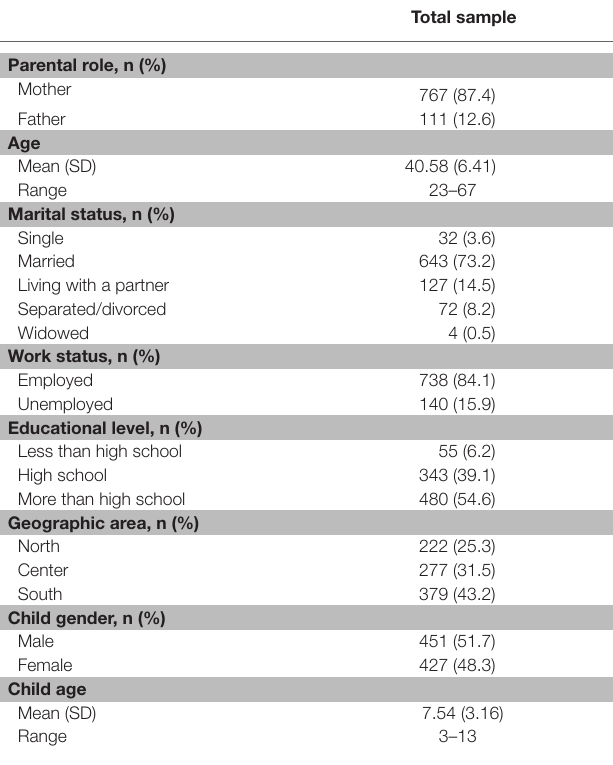
TABLE 1 | Descriptive characteristics of the sample ( n =